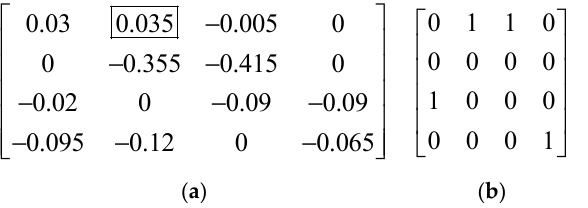
Figure 4. The utility and assignment matrix for the pharmacy CSC. ( a ) utility matrix; ( b ) assign- ment matrix. matrix.